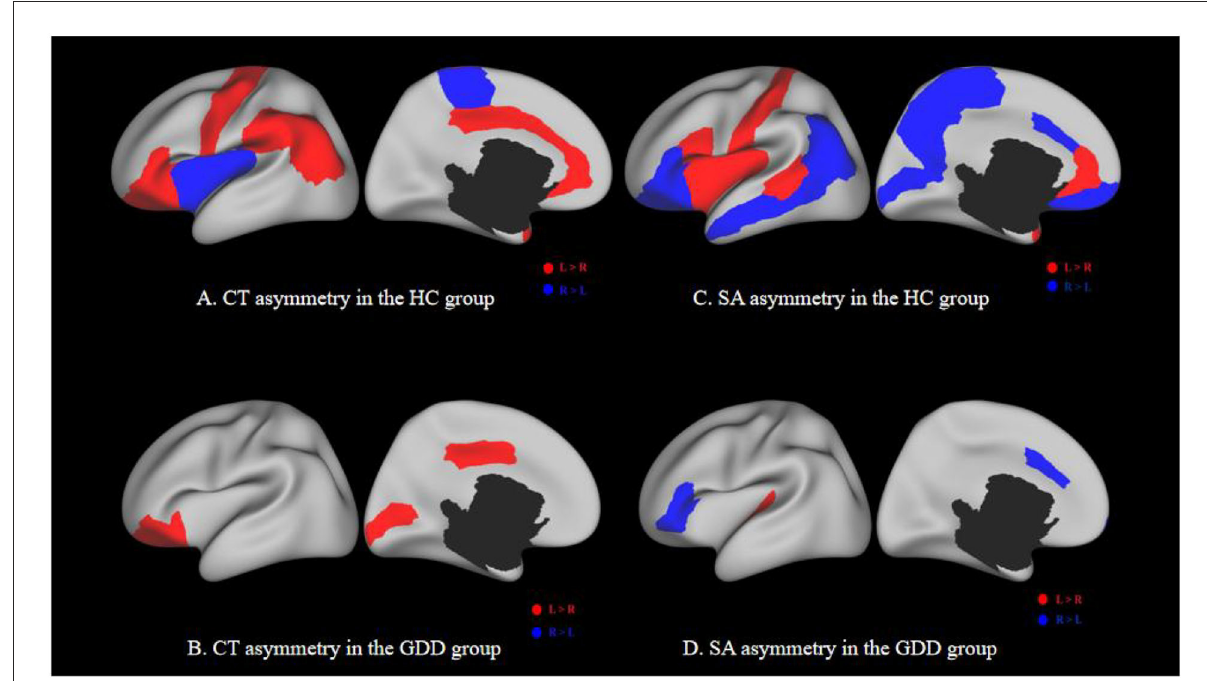
FIGURE5 (A,C) show the asymmetry of CT and SA between two hemispheres of the HC group. (B,D) show the asymmetry of CT and SA between two hemispheres of the GDD group. Each image has a lateral view on the left and a medial view on the right. Red indicates a higher CT/SA in the left hemisphere of the same region than the right, while blue indicates the opposite. The black hole in the medial view indicates the medial wall between two hemispheres.